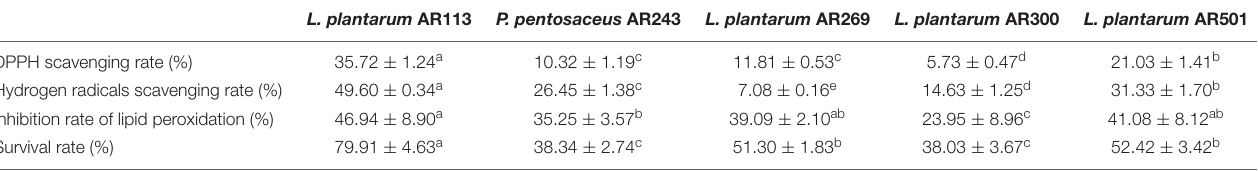
TABLE 1 | Antioxidant activity of LAB in